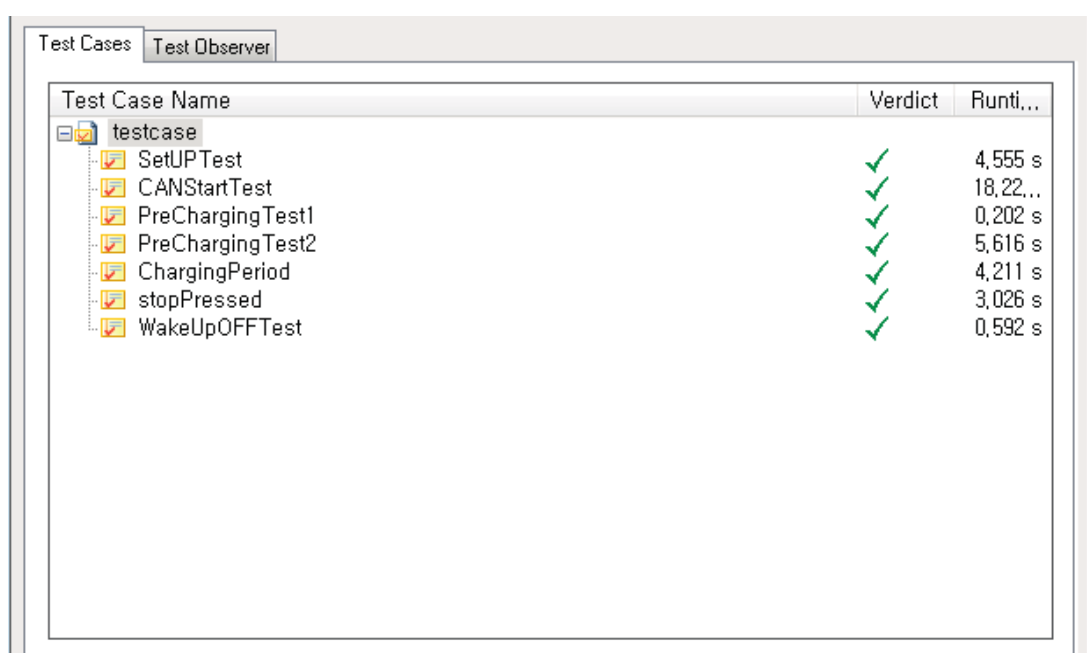
Figure 9. Pressing the stop button test mode.